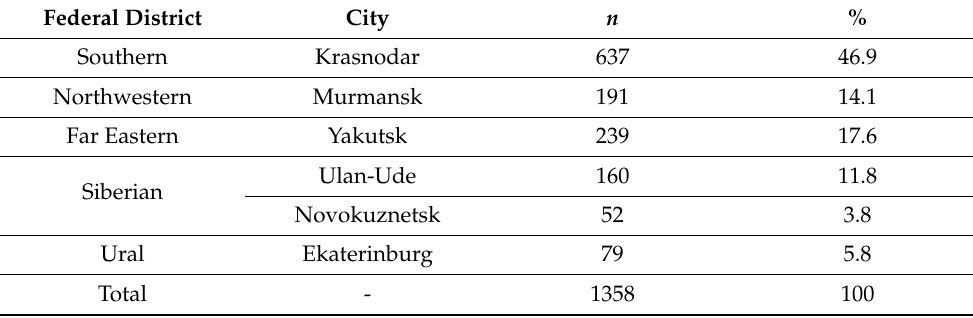
Table 1. Geographical distribution of participating centers and proportion of